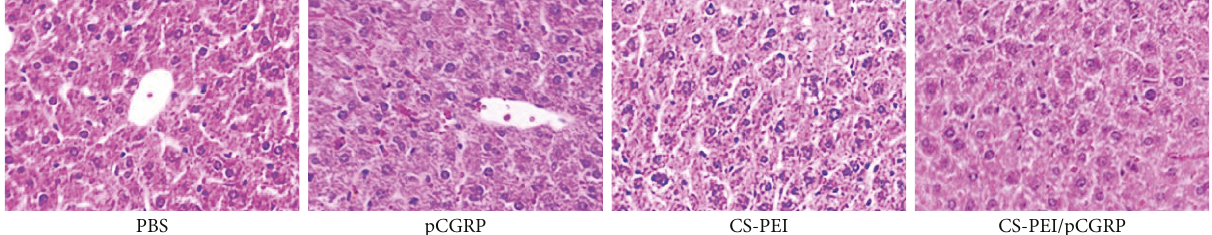
Figure 10: The histological section of rat liver after 3 weeks with di ff erent treatments of pCGRP, CS-PEI, or